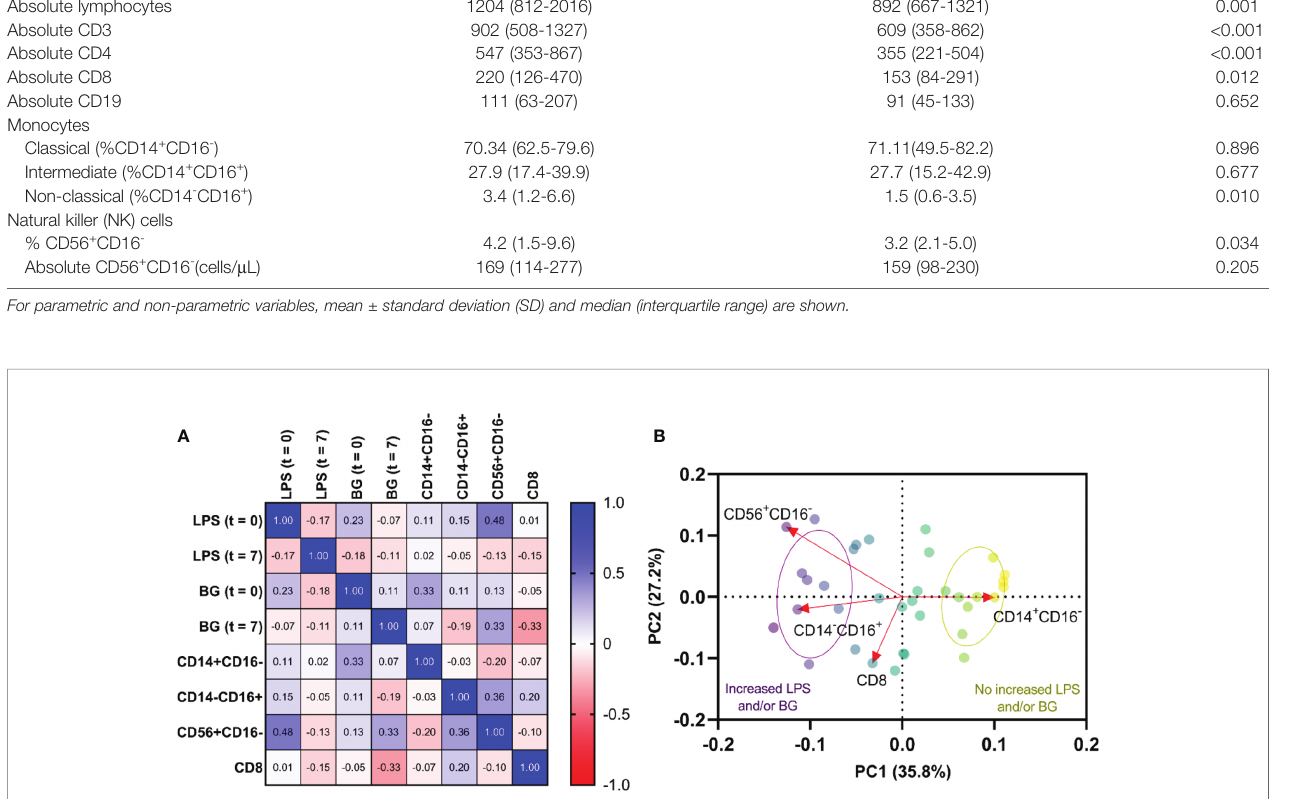
FIGURE 4 | Relationship among lipopolysaccharide (LPS), (1 ! 3)- b -D-glucan (BG), and immune pro fi les. Correlations of LPS and BG among monocytes(CD14 + CD16 - and CD14 - CD16 + ), natural killer (NK) cells (CD56 + CD16 - ), and cytotoxic T cells (CD8 + ) at time of enrollment ( t = 0) and day 7 of illness ( t = 7) (A) . Principal component analysis of immune cells with increased LPS and/or BG and without increased LPS and/or BG (B) . Red arrows represent gradients of the corresponding immune cells and point to the direction of greatest increase in these measures. Color of the circles represents the combination of LPS and/or BG subgroups, and ellipses represent standard deviation (SD) of the